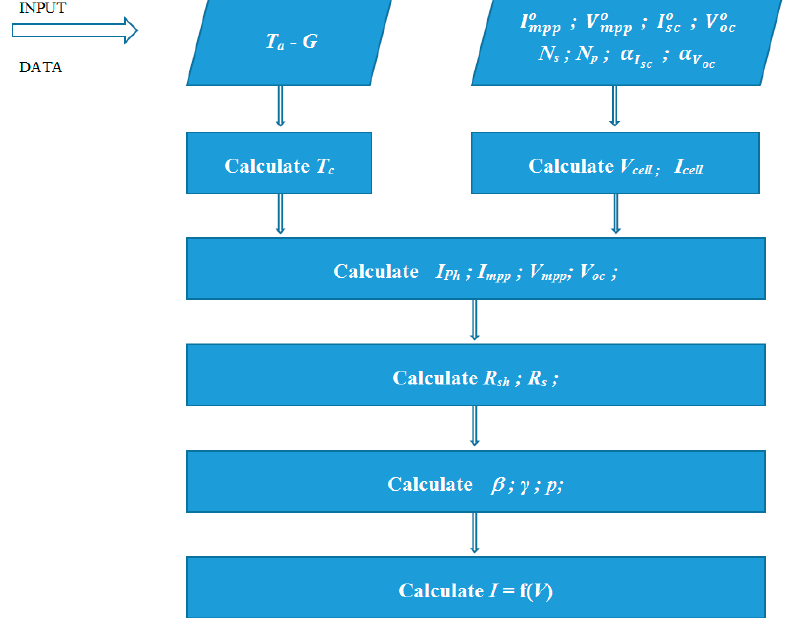
Figure 3. Calculation scheme to get the relationship between current and voltage of a photo-voltaic (PV) cell.